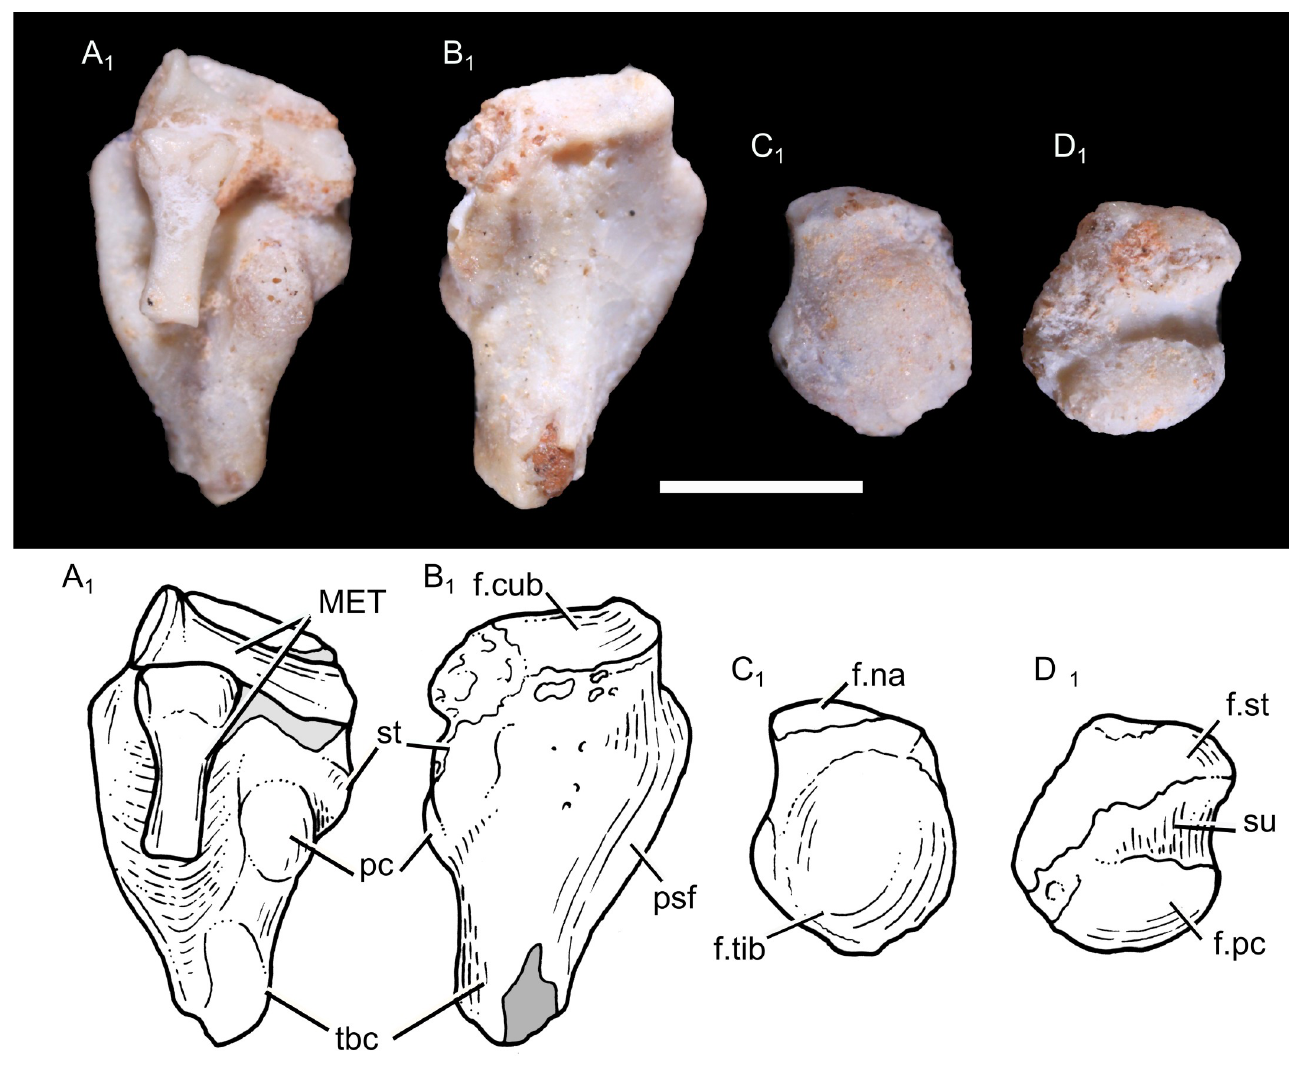
Fig 8. Photography (1) and drawing (2) of the calcaneum and astragalus of Brasilodon quadrangularis (UFRGS-PV-1043-T). A , left calcaneum, in dorsal view; B , left calcaneum, in plantar view; C , left astragalus, in dorsomedial view; D , left astragalus, in lateroplantar view. Abbreviations: f.cub , facet for the cuboid; f.na , facet for the navicular; f.pc , facet for the proximal facet of the calcaneum; f.st , facet for the sustentaculum tali; f.tib , facet for the tibia; MET , metatarsus; pc , proximal facet of the calcaneum for the astragal; psf , peroneal shelf; st , sustentaculum tali; su , sulcus of the astragalus (tarsal sinus); tbc , tuber calcis. Scale bar = 2